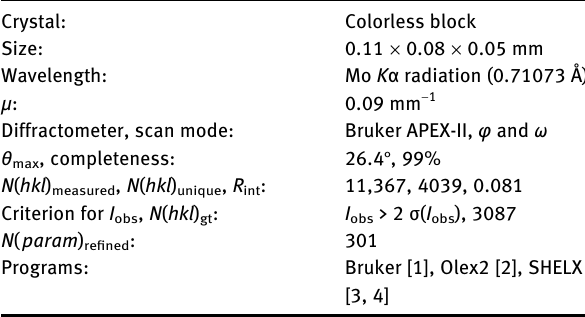
Table  : Data collection and